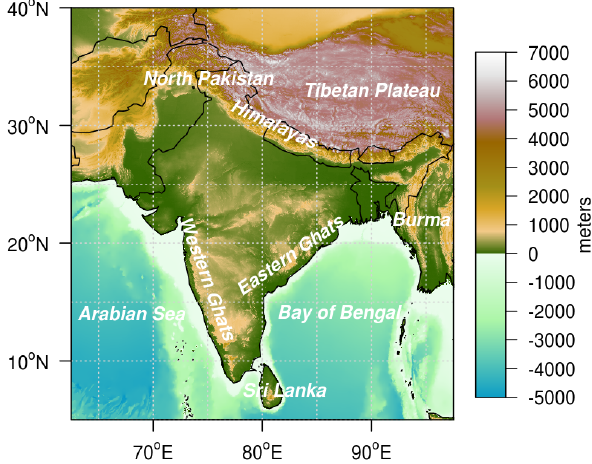
Figure 1. Regional overview of the Indian subcontinent. Major to- pographic and political features referred to in the text are labeled in white, and the background image is based on the Shuttle Radar Topography Mission (SRTM30) gridded digital elevation model, which is available at GEBCO